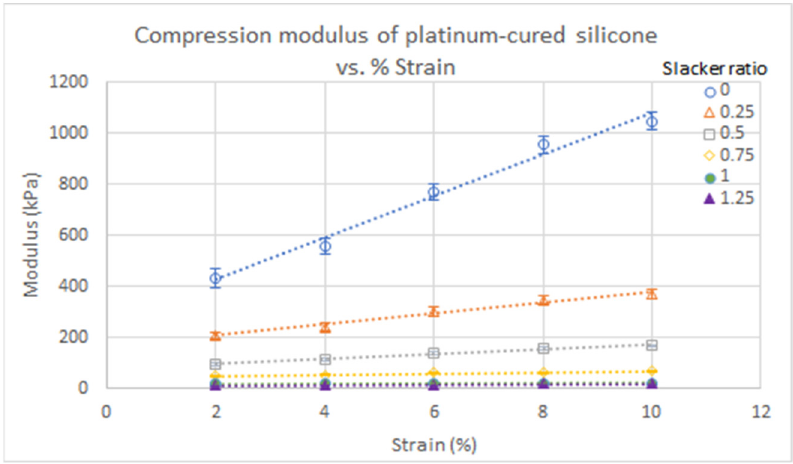
Figure 3. Compressive moduli of platinum-cured silicone at various % strains relative to sili- cone:Slacker ratio.